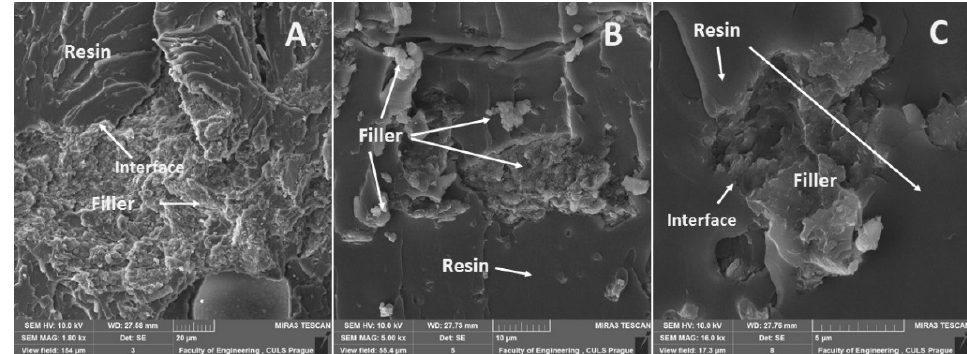
Figure 8. SEM micrographs—static tensile test of composite materials: ( A ) fracture surface of adhesive E53/TFF/100:22/ZR-2 (mag 1.8k×), ( B ) fracture surface of adhesive E53/TFF/100:22/ZR-2 (mag 5.0 k×),